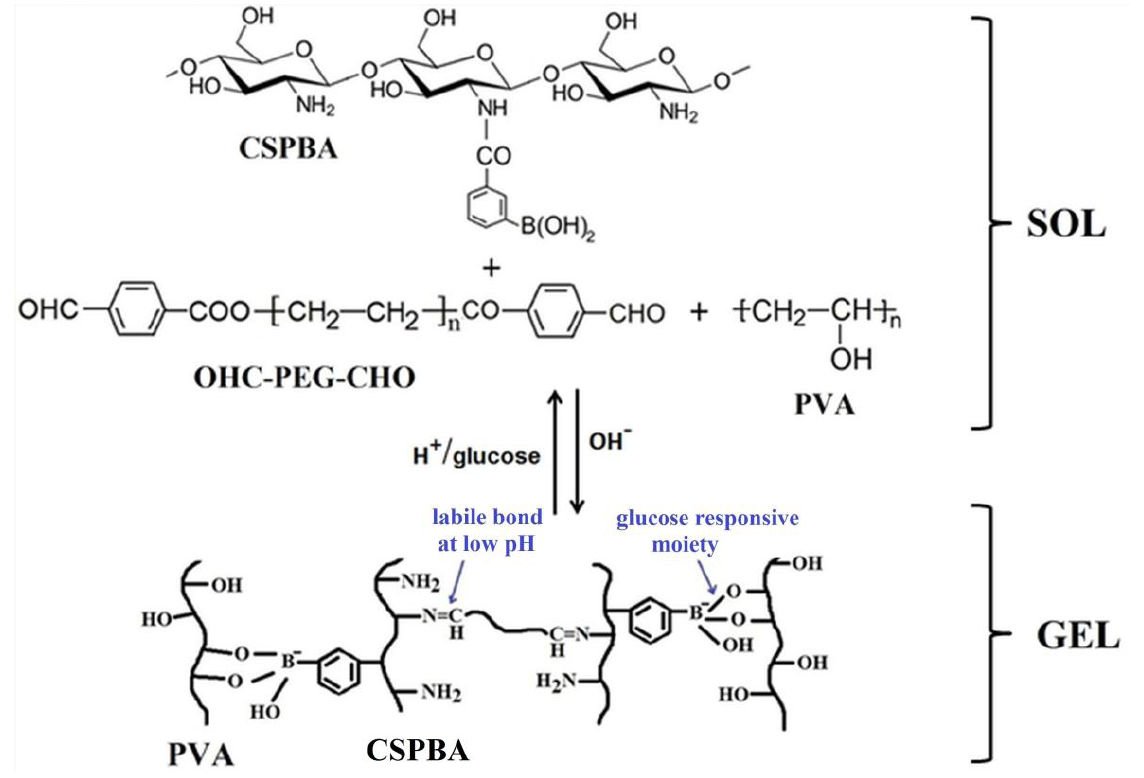
Figure 7. Structure of pH- and glucose-responsive CSPBA/PVA/OHC-PEG-CHO hydrogel (Adapted with permission from [83]. Copyright © 2023, American Chemical Society).